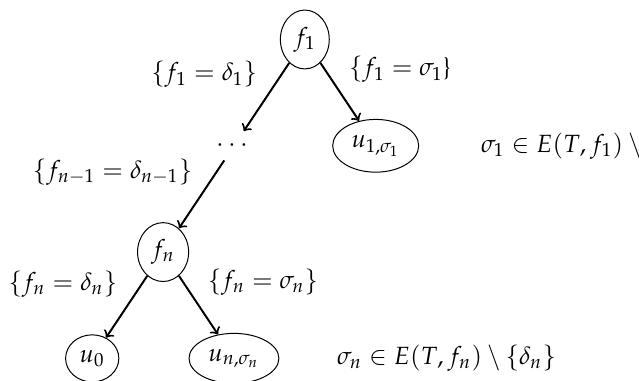
Figure 2. Prefix of decision tree Γ ∗